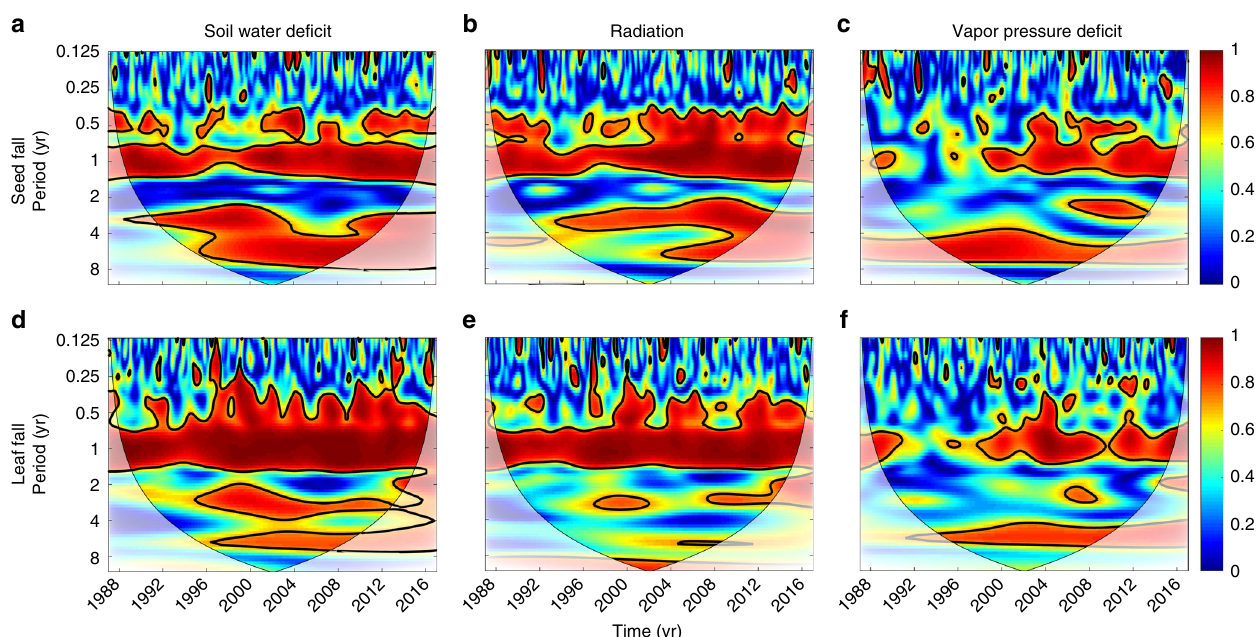
Fig. 3 The in fl uence of climate on phenology at multiple temporal scales. Wavelet coherence analysis of seed fall ( a , b , c ) and leaf fall ( d , e , f ) with local climate variables indicates strong connections at both seasonal (1 year) and ENSO cycles (2 – 7 year). Red regions bounded by black contour lines indicate signi fi cant coherence ( α < 0.05). Lighter shading indicates areas outside the cone of in fl uence within which there are suf fi cient data to reliably test patterns at particular periods and times